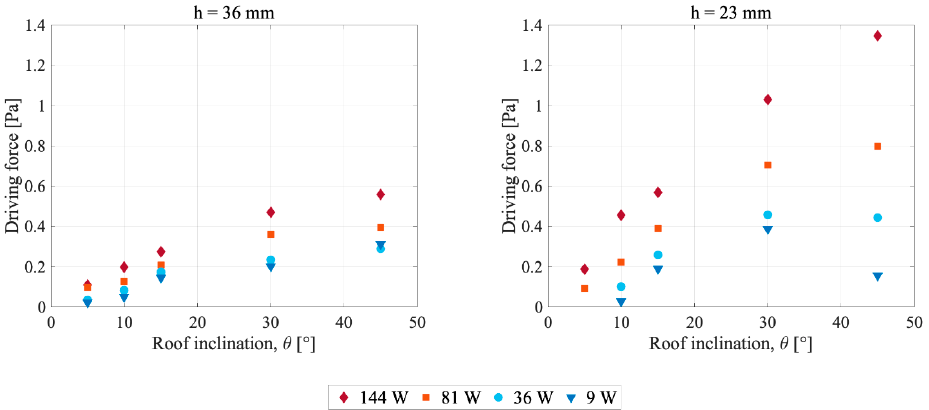
Figure 10. Thermal driving force at different roof inclinations, air cavity heights and applied heating power.